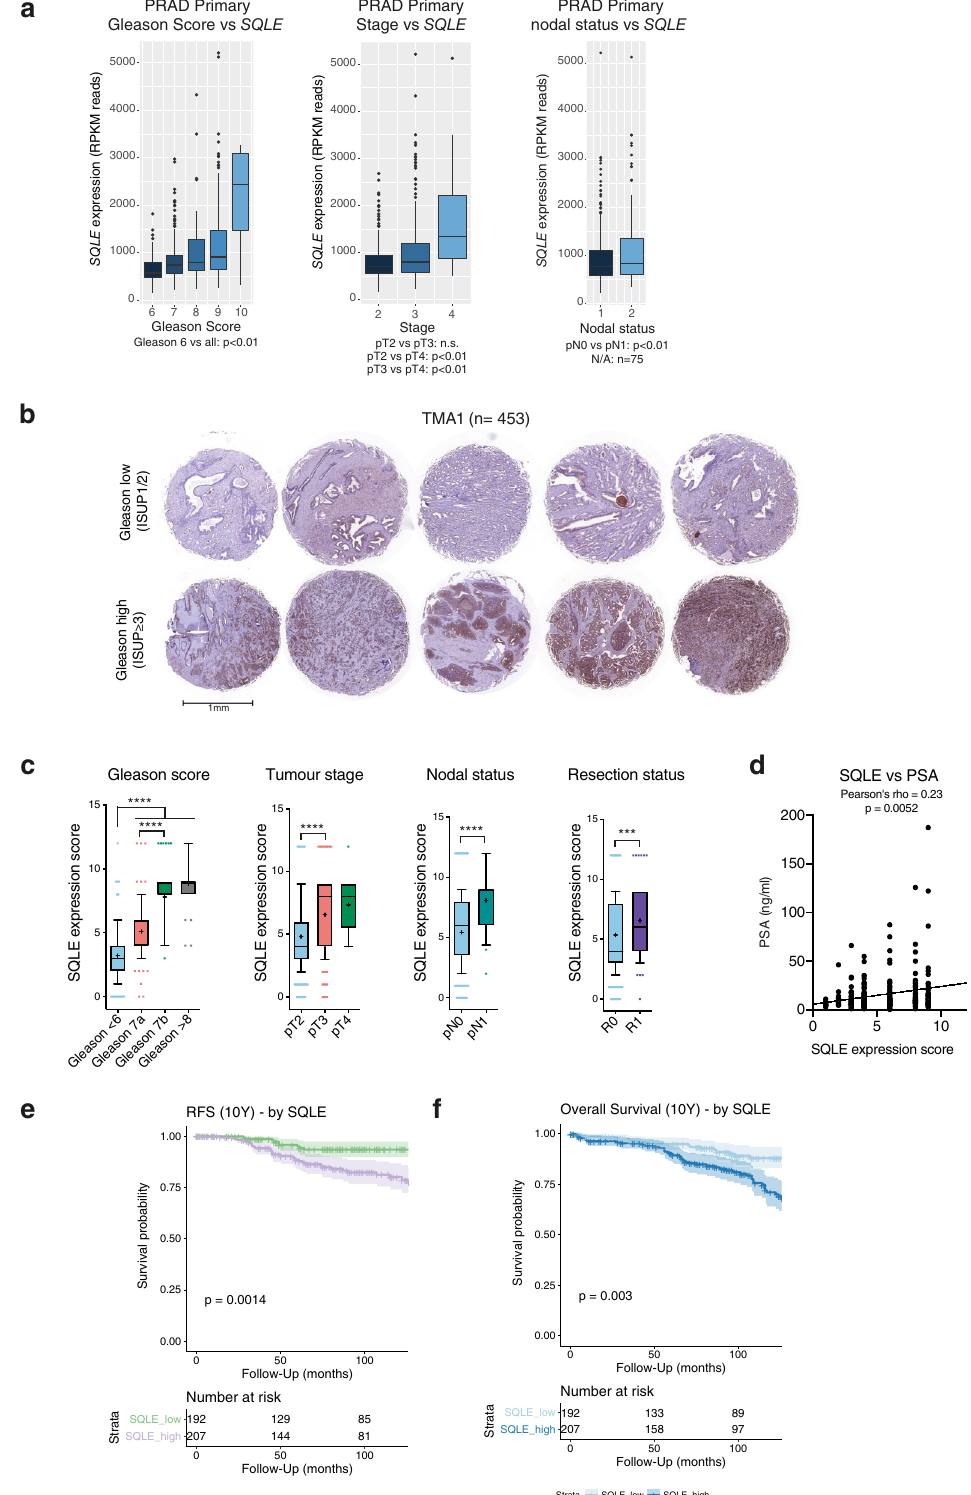
tissues ( N = 10). This revealed that SQLE mRNA levels were (LNCaP-Abl-Abi) and enzalutamide-resistant inversely correlated with miR-205 expression across the entire (LNCaP-Abl-Enza) derivatives of the LNCaP cell line (Fig. 2e). cohort and along the line of progression from benign to primary To assess the correlation between miR-205 and SQLE tumour and to lymph-node metastasis (Fig. 2f). Moreover, expression, we analysed an in-house collection of formalin- fi xed, elevated SQLE mRNA expression was signi fi cantly elevated in paraf fi n-embedded tissue samples consisting of primary PCa tumours with advanced stage, Gleason score and resection status ( N = 59), lymph-node metastasis ( N = 22), and benign prostate NATURE COMMUNICATIONS| (2021) 12:5066